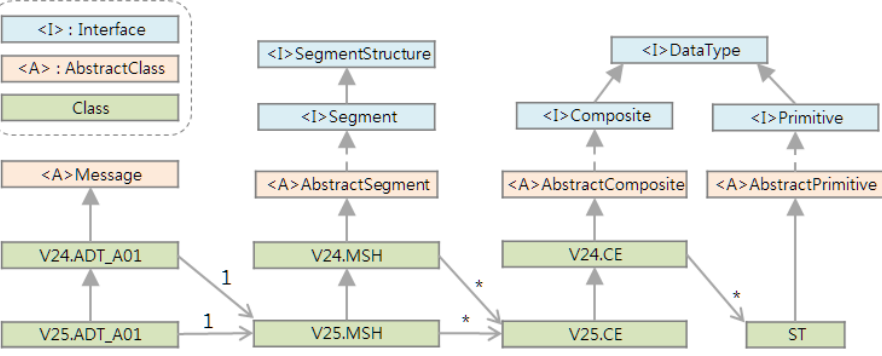
Fig. 1. OOD-based structure of HL7 V2